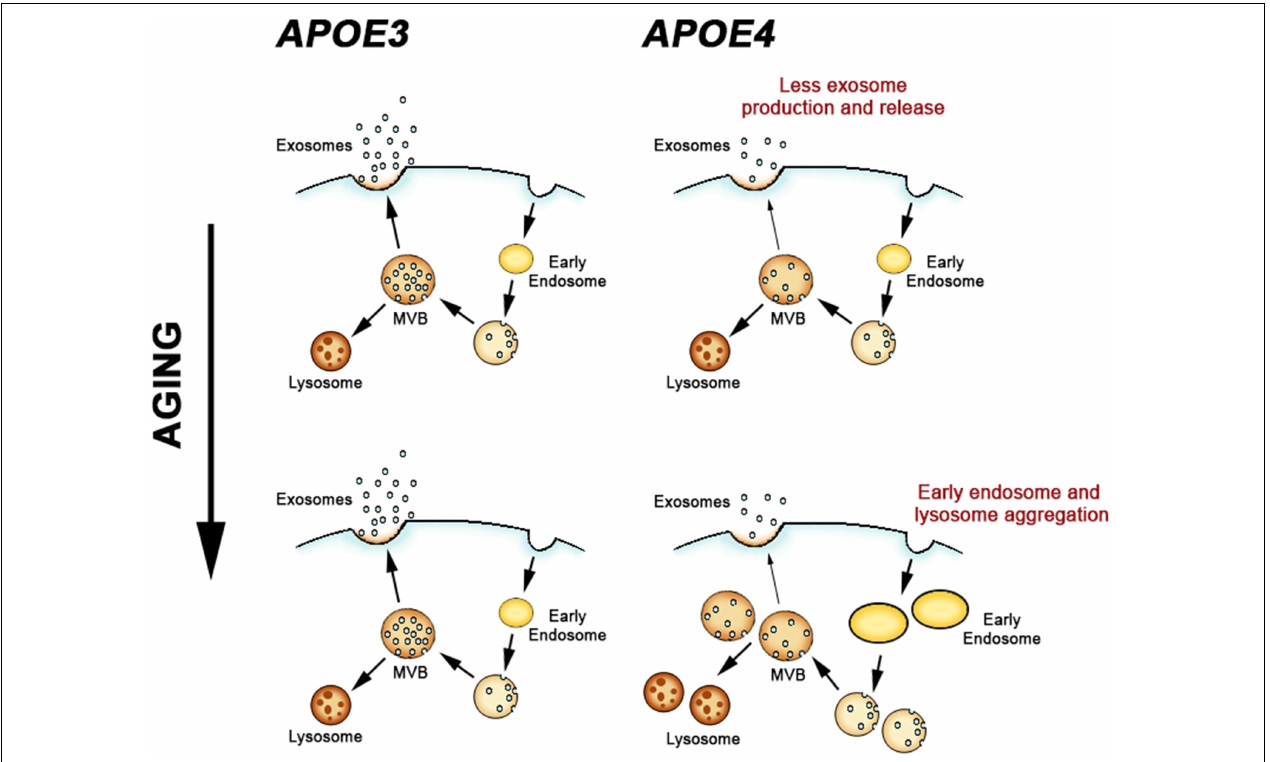
FIGURE 3 | Apolipoprotein E-genotype effects on the endosomal and exosomal pathways. APOE4 expression leads to a deficiency in exosome generation and release in the brain, which subsequently leads to pathogenic alterations in early endosomes and lysosomes during